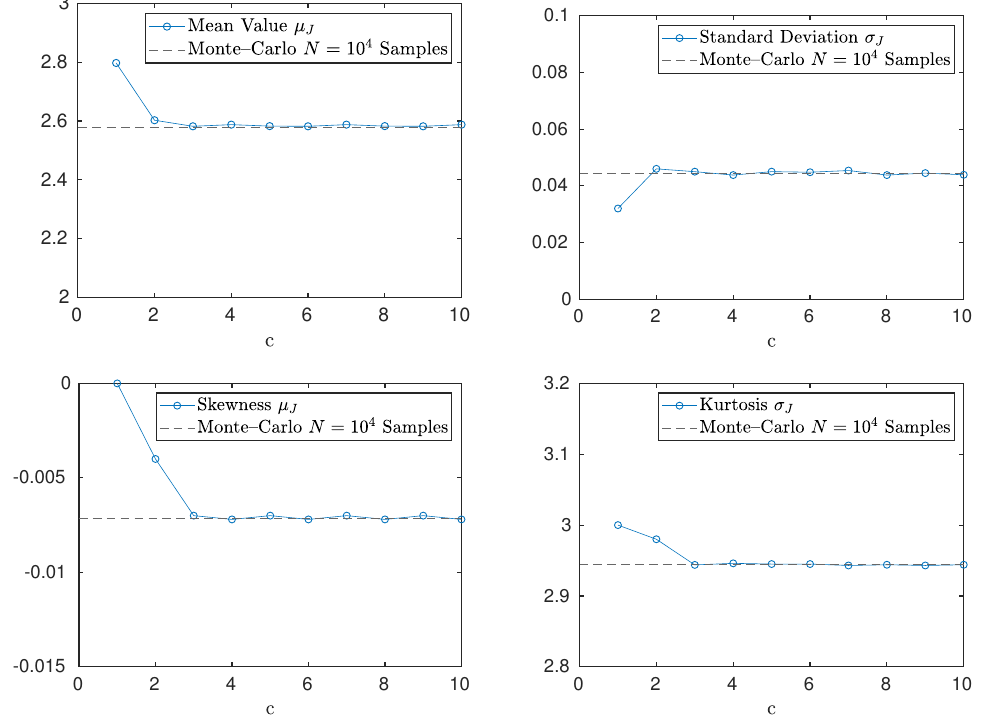
Figure 3. Spectral convergence of the first four moments of the Quantity of Interest (QoI) (32) in the Lorenz-96 system. Here, T = 100, F = 10 + 0.3 ξ , where ξ ∼ N ( 0,1 )